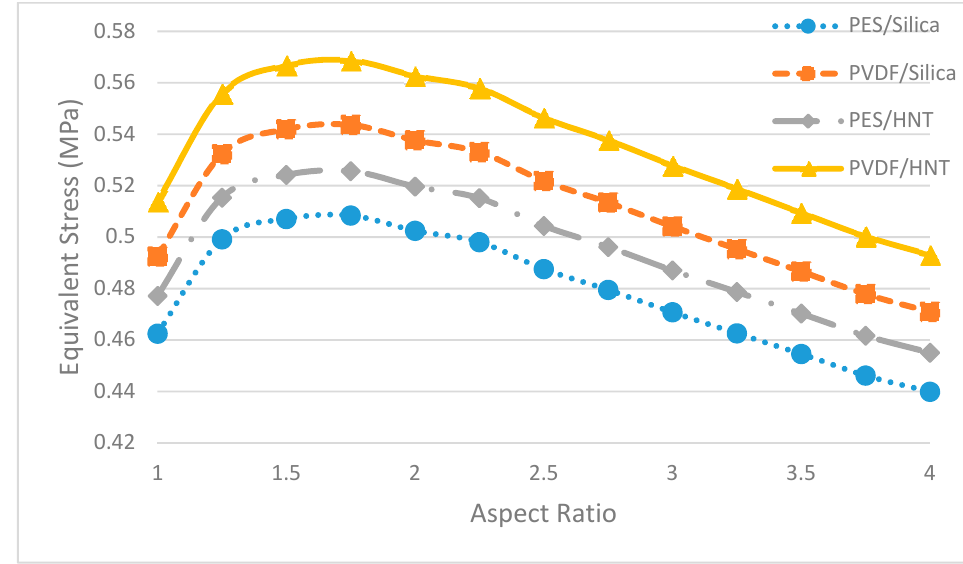
Figure 17. Maximum equivalent stresses of nanocomposite membranes of different aspect ratios.